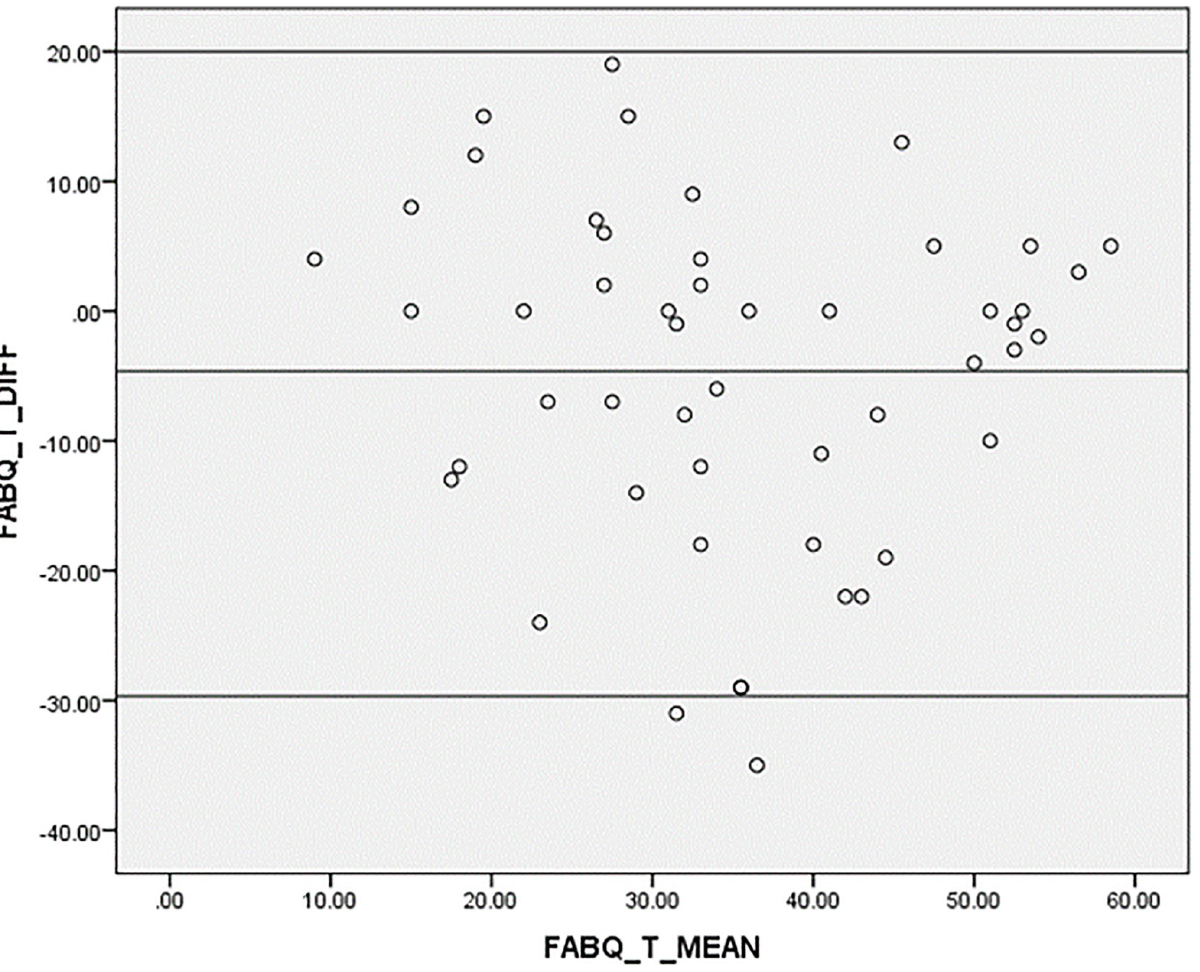
Fig 2. Bland-Altman plot for test-retest agreement of Igbo-FABQ (total). [upper limit: (+1.96 SD): 20.39; mean: -4.64 (-8.27, -1.01); SD: 12.77; lower limit: (-1.96 SD): -29.67].